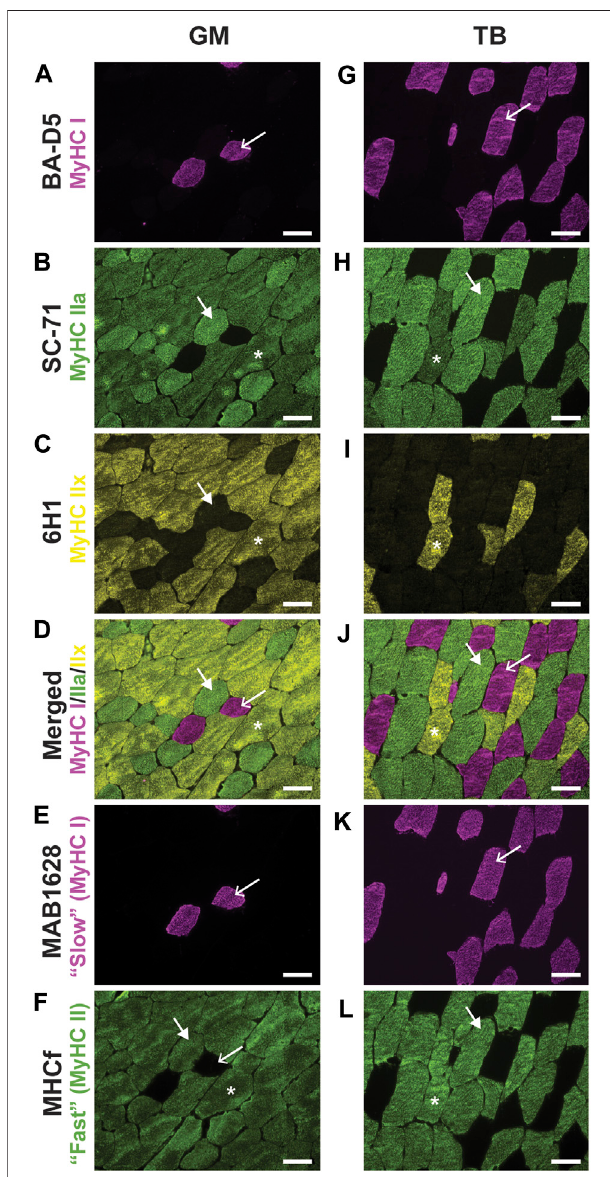
FIGURE 1 | Representative images of fl uorescent staining of horse gluteusmedius(GM)andtricepsbrachii(TB)myosinheavychain(MyHC)typeI using primary antibodies BA-D5 (A , G) and MAB1628 (E , K) , MyHC type IIa usingtheprimaryantibodySC-71 (B , H) ,MyHCtypeIIxusingtheprimary antibody 6H1 (C , I) , a merged image of concurrently stained BA-D5, SC-71, and 6H1 (D , J) , and MyHC type IIa and IIx using the primary antibody MHCf (F , L) . Within a column, arrows point to the same fi ber. Arrow, MyHC type I (pink); large arrowhead, MyHC IIa (green); asterisks indicate type IIa/x hybrid fi bers. No pure MyHC IIx (yellow) fi bers were noted in these sections. Scale bar, 100 µm.